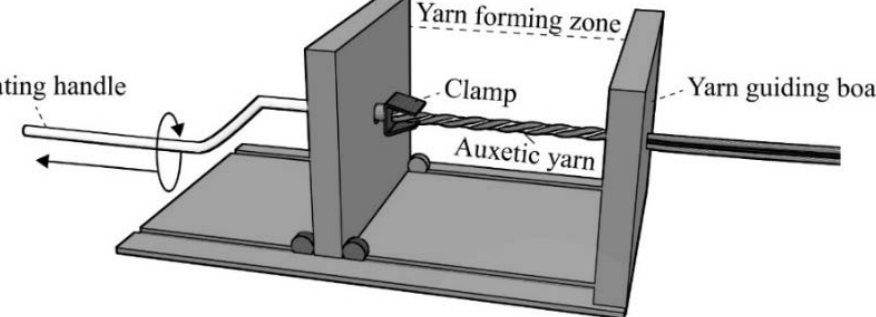
Figure 3. Schematic diagram of the HAY spinning device.